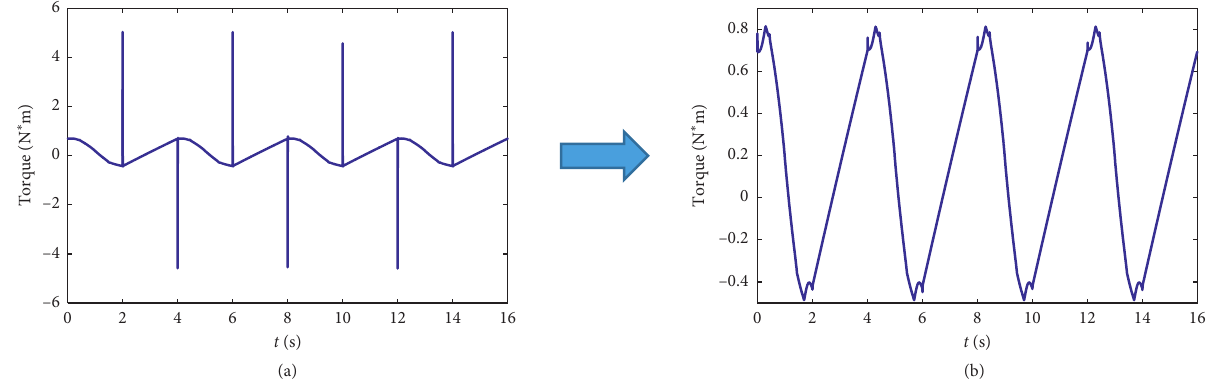
Figure 15: Driving torque curve of the thigh motor. (a) Unmodified curve. (b) Modified curve.